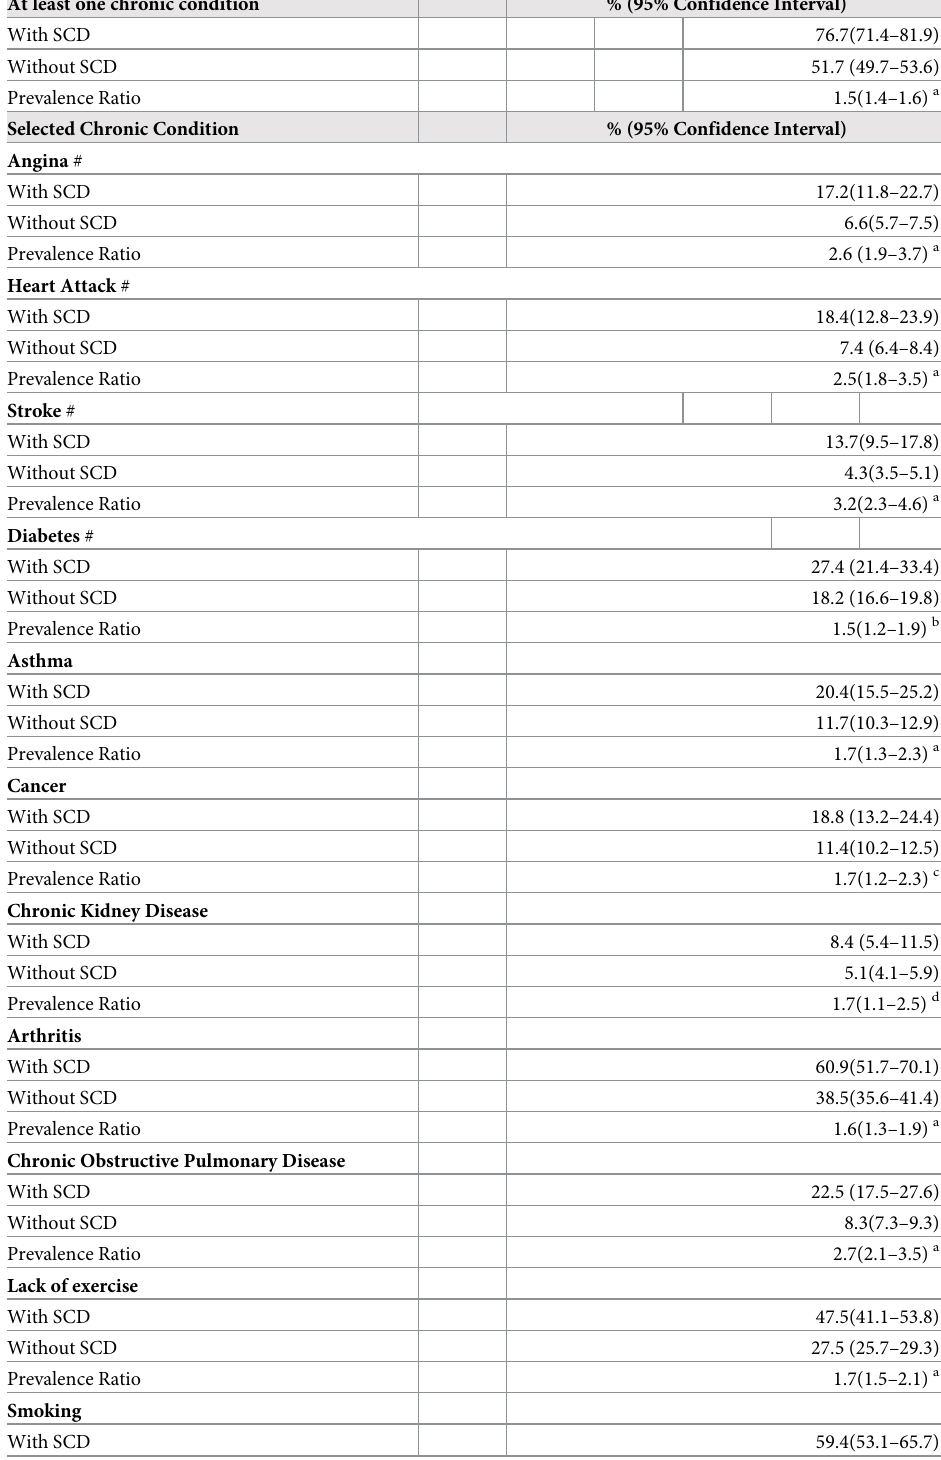
Table 2. Delaware Adults Aged 45 Years or Older Who Reported Comorbid Chronic Diseases/Cognitive Risk fac- tor by Subjective Cognitive Decline (SCD) Status, Behavioral Risk Factor Surveillance System (BRFSS)